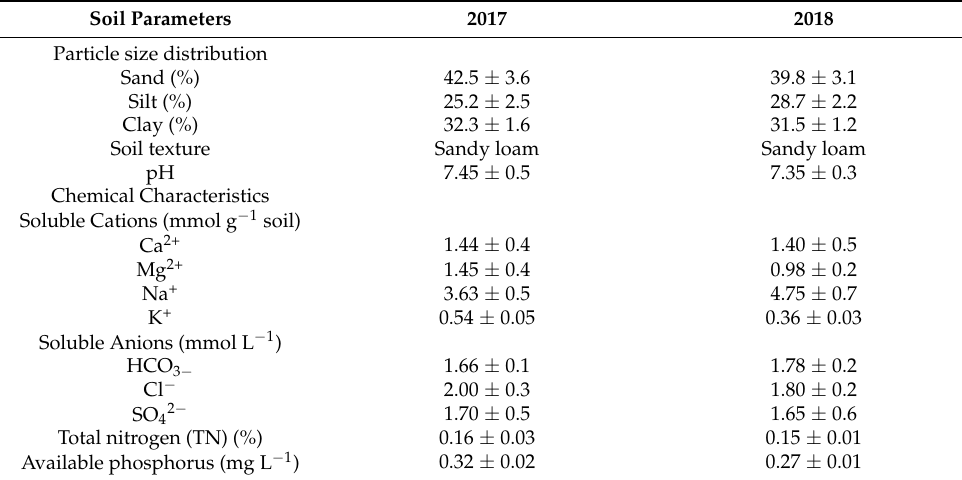
Table 2. Chemical and physical characteristics of the soil at the experimental location, during the growing seasons of 2017 and 2018.